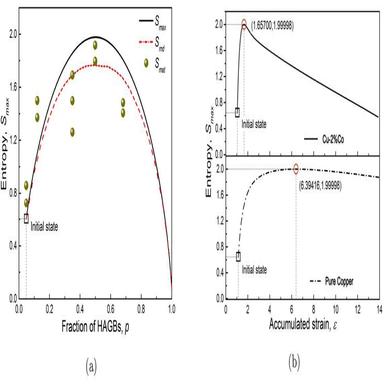
Evolution of structural entropy: (a) simulation curves for Srnd, Smax and experimental points Smat. (b) evolution of Smax with accumulated plastic strain in Cu-2%Co and pure copper alloy during ECAP.